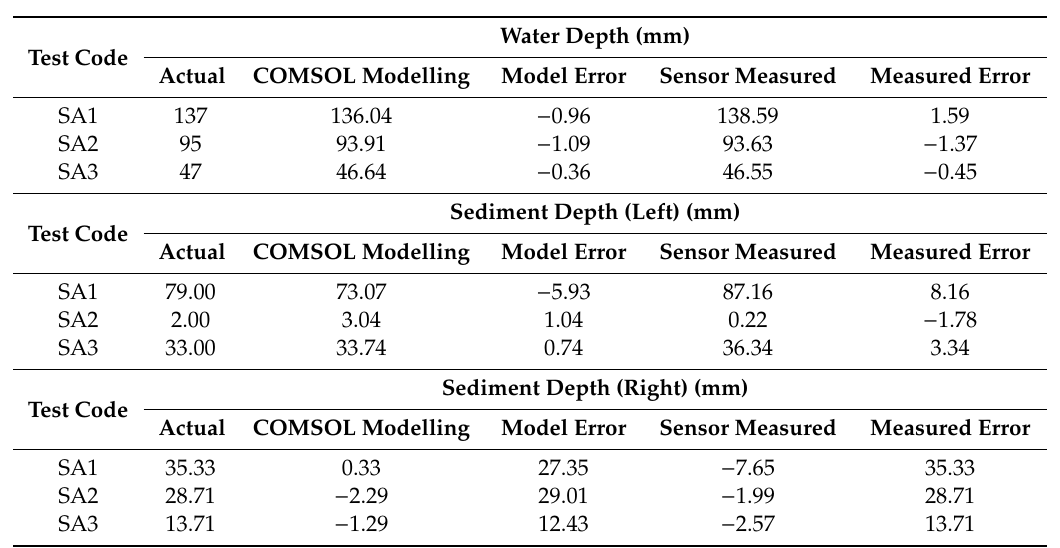
Table 4. Depth results summary of rotated sediment